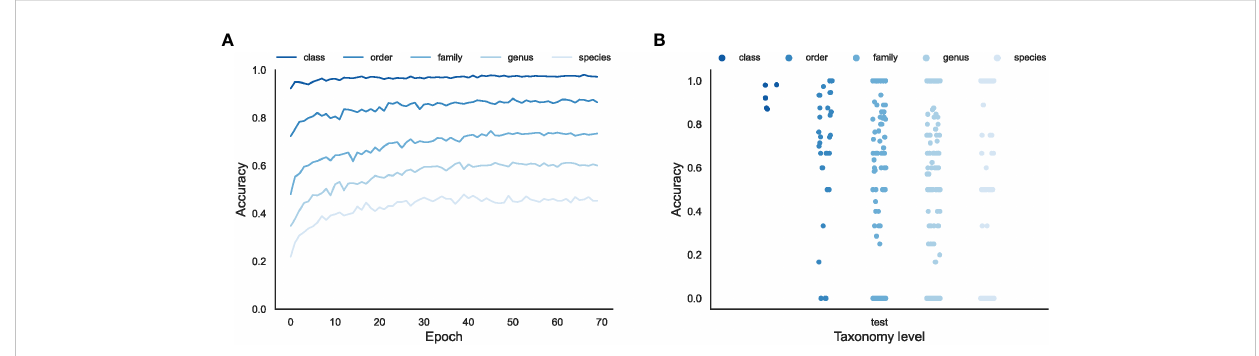
FIGURE 3 The overall effectiveness of the EchoAI models for the test set at different taxonomic levels. (A) the change of accuracy over Epoch; (B) the distribution of accuracy for each taxon (represented by the point) predicted by the optimized